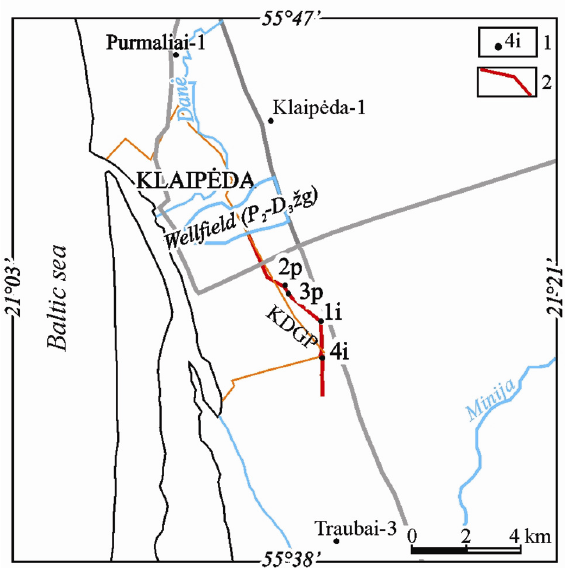
Fig. 1. Setting of Klaipėda demonstration geothermal plant (KDGP) and modelled area: 1 – well and its name; 2 – direction of model profiles